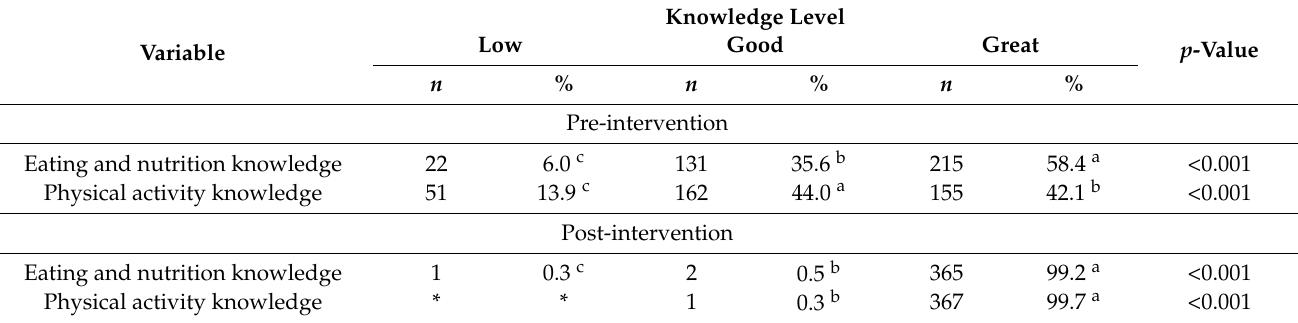
Table 2. Children’s responses prevalence to questions about knowledge about eating, nutrition, and physical activity in the pre- and post-intervention